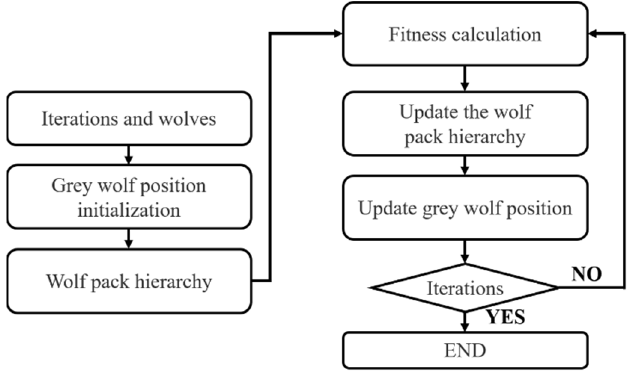
Figure 8. The architecture of the GWO.